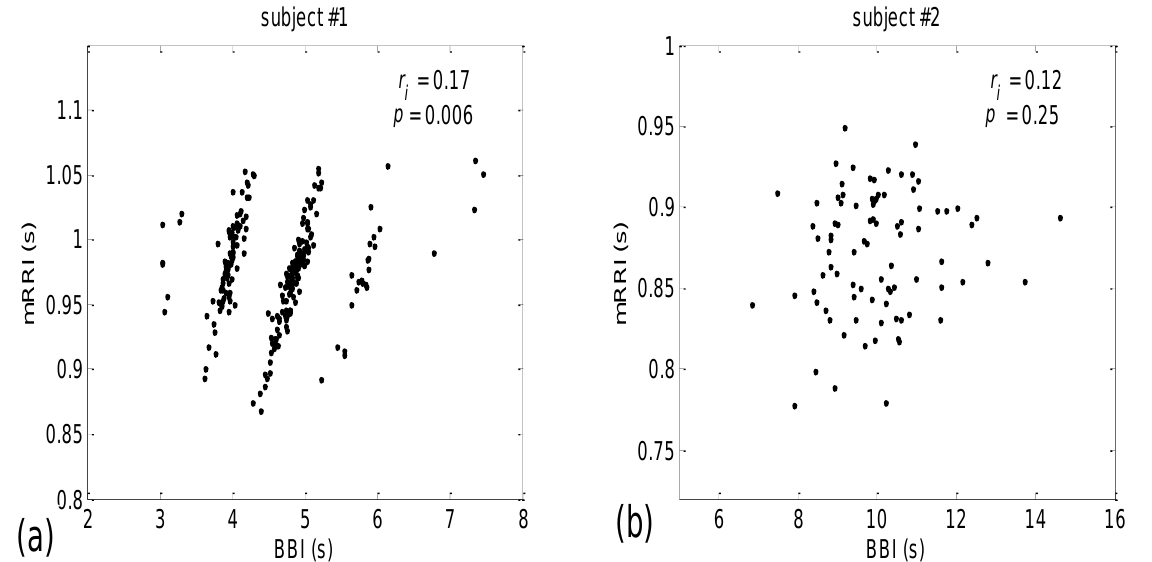
Figure 2. Examples of two types of scatter plots ( BBI and mRRI ) obtained from subjects #1 and #2 in supin and stand01 experimental conditions, respectively. ( a ) Subject #1 (supin), with pronounced quasi-linear clusters; ( b ) subject #2 (stand01), with no apparent clusters and with points randomly scattered. Upper right corner: r i — the integral (not cluster-averaged) coefficient of linear correlation is low and bears little physiological relevance; p is the corresponding significance level of r i .